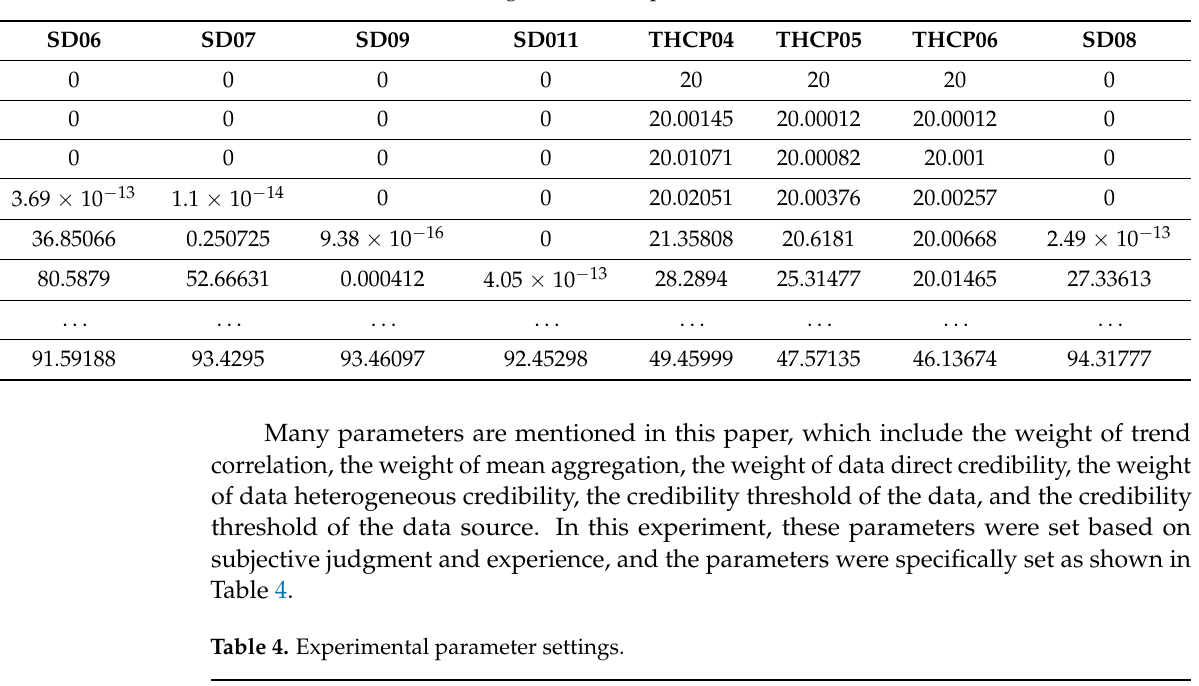
Table 3. Original data sample.